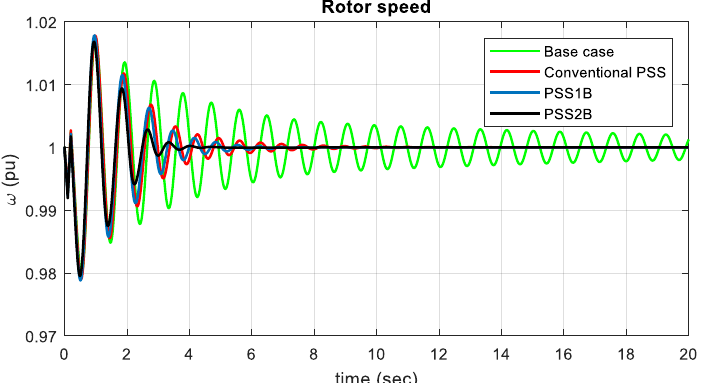
Figure 16. Rotor speed ( ω ) of the power system at normal loading.